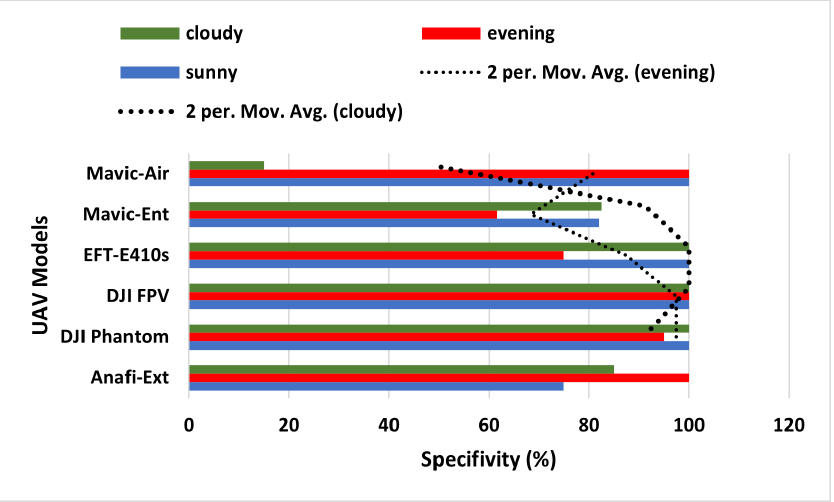
Figure 10. Specificity graph of ALIEN performance for detecting UAV models across all